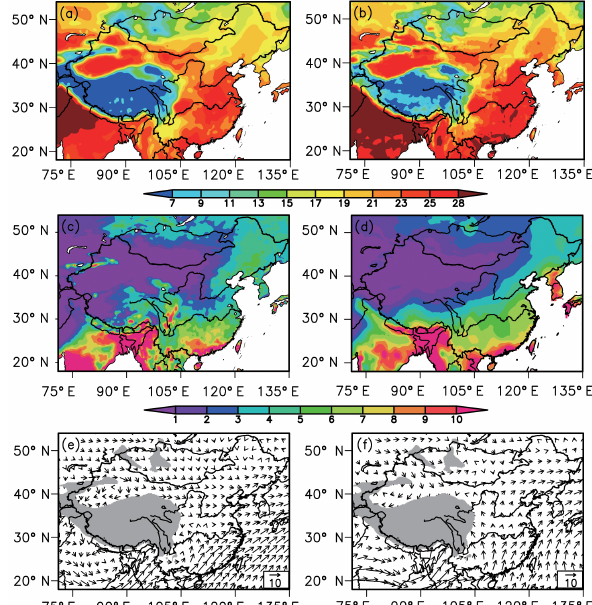
Figure 2. Spatial distribution of (a, b) summer surface air tempera- ture ( ◦ C) and (c, d) summer precipitation (mmday − 1 ) simulated in the control experiment (a, c, e) and the CRU observations (b, d, f) for 1990–2009. The bottom two panels are wind vectors at 850hPa simulated in (e) the control experiment and (f) the NCEP–DOE re- analysis during the summer monsoon season (June–August) aver- aged for